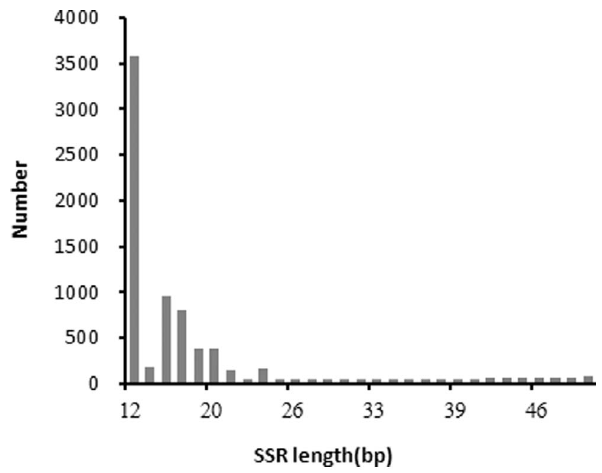
Figure 3. Distribution between SSR length and number of SSRs.